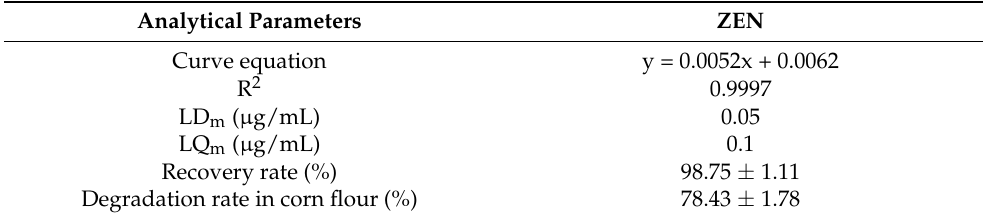
Table 3. Parameters of detection of ZEN in corn flour ( n = 3). Analytical